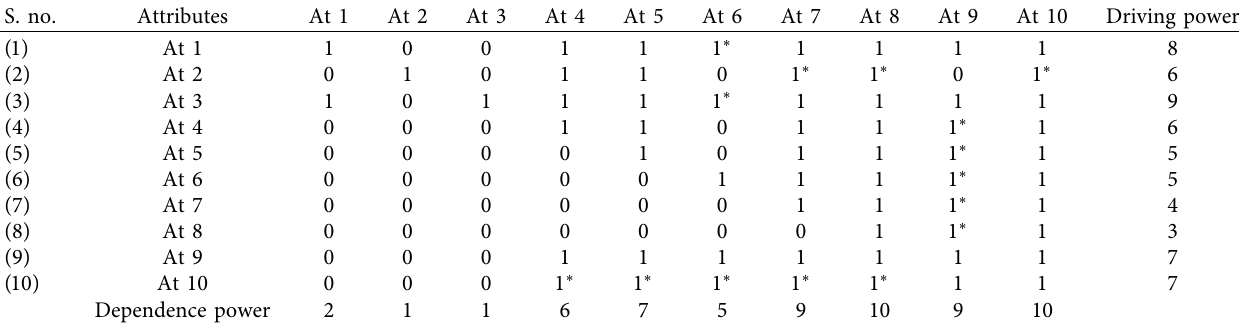
Table 4: Final reachability matrix with transitive links.